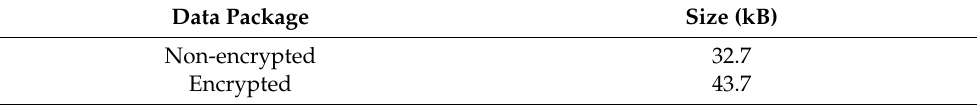
Table 10. Size comparison between encrypted and non-encrypted data packages.